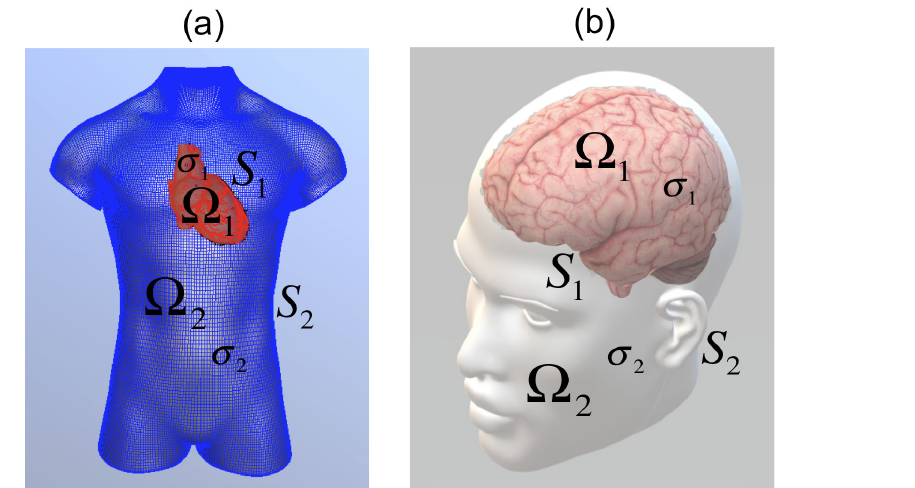
Fig 1. Region O = O 1 [ S 1 [ O 2 . The source g is defined on the boundary S 1 for (a) ECG and (b) EEG.